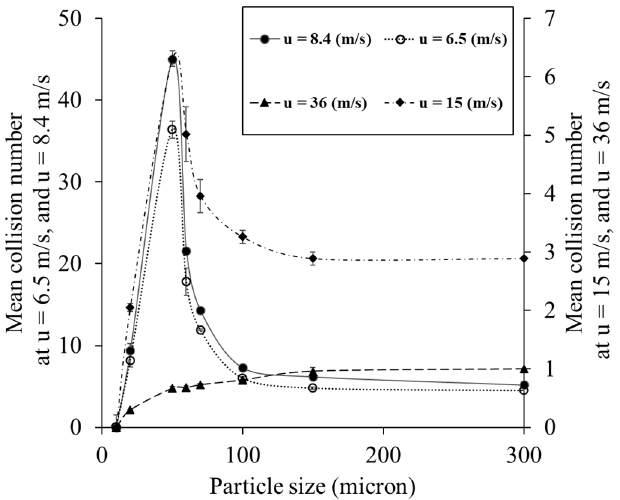
Figure 7. Influence of air velocity on particle-wall mean collision numbers. All calculations were accomplished for a single pipe length (1 m) and diameter (4.76 mm). accomplished for a single pipe length (1 m) and diameter (4.76